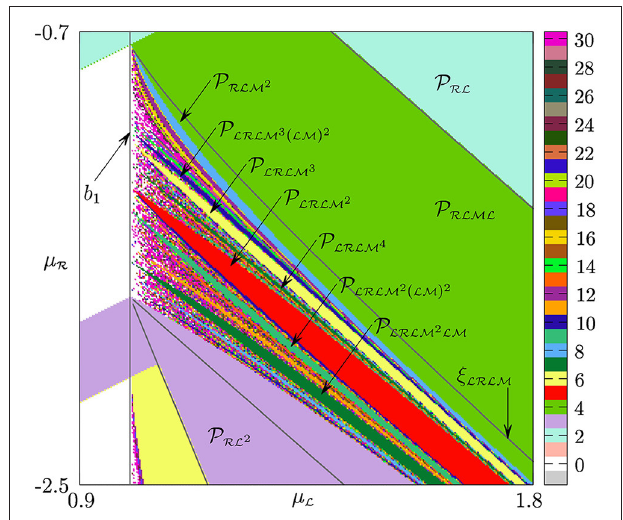
FIGURE 9 | Periodicity regions related to “stabilized” versions of U-sequence cycles in the limit case a R = 0.